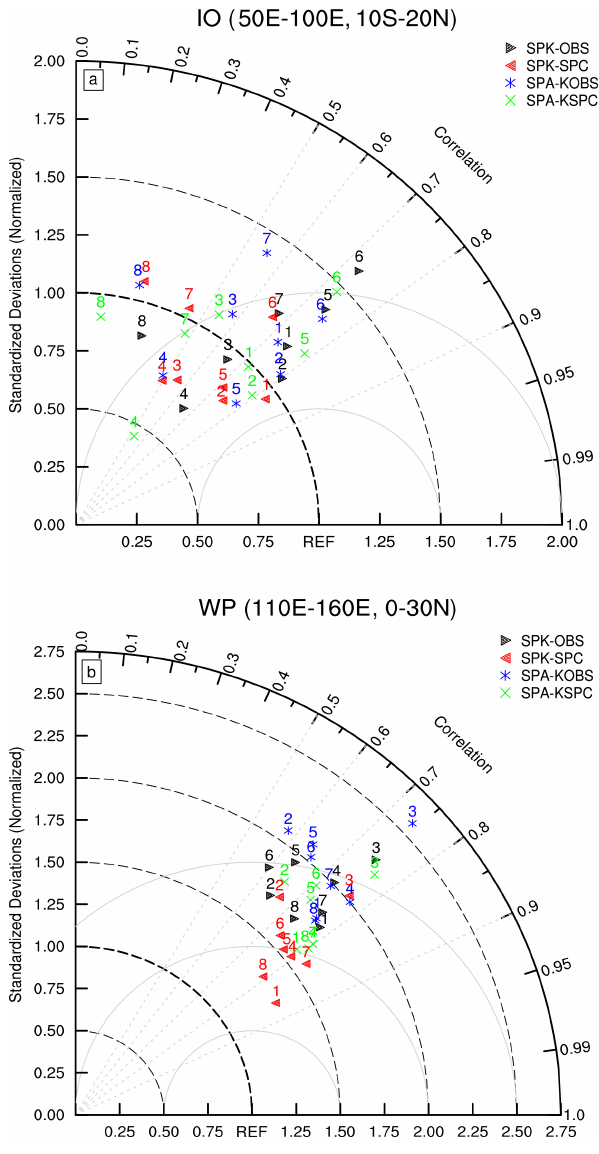
Figure 12. Taylor diagrams for anomalous precipitation in each BSISO phase averaged over (a) the Indian Ocean (IO; 10 ◦ S–20 ◦ N, 50–100 ◦ E) and (b) western Pacific (WP; 0–30 ◦ N, 110–160 ◦ E). The number above each symbol refers to the BSISO